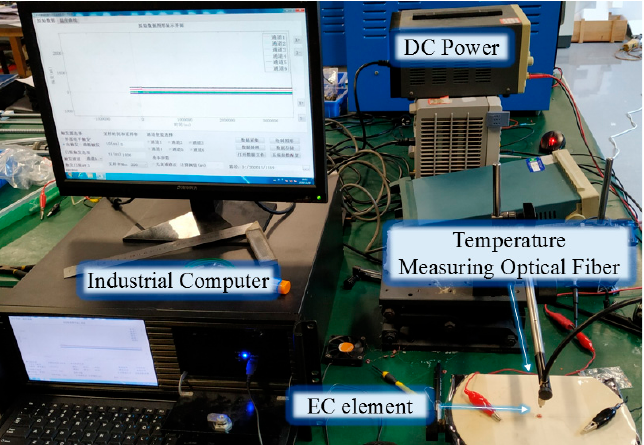
Figure 3. Transient high temperature testing system.